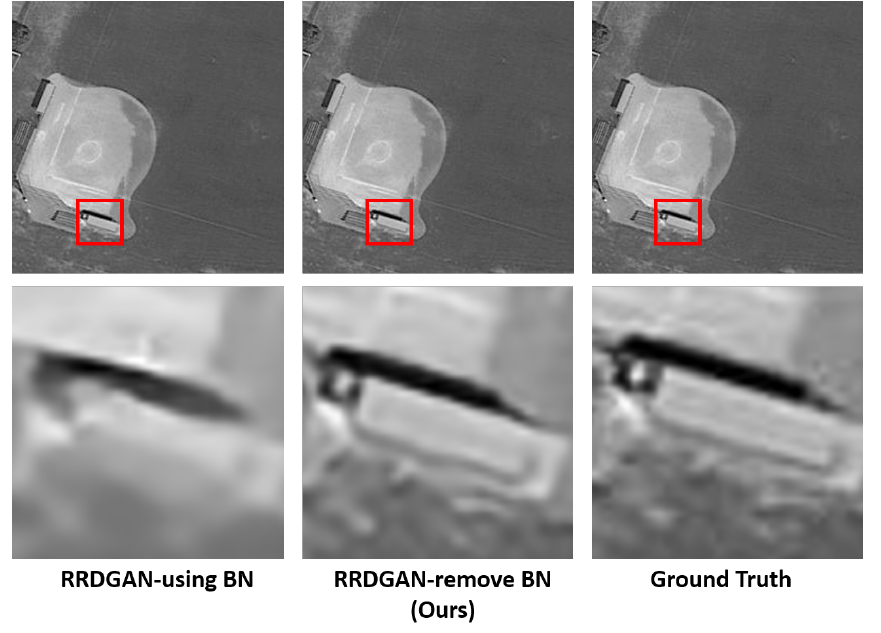
Figure 14. The influence of batch normalization.